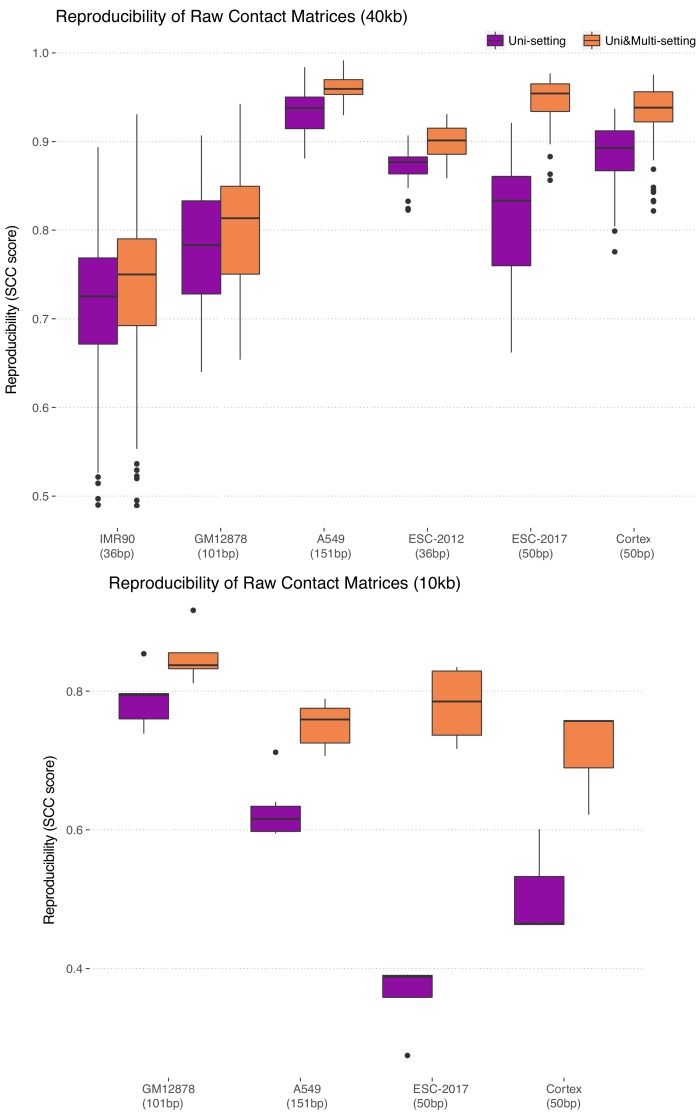
Reproducibility at the contact matrix level at resolutions 40 kb (low) and 10 kb (high) across study datasets.